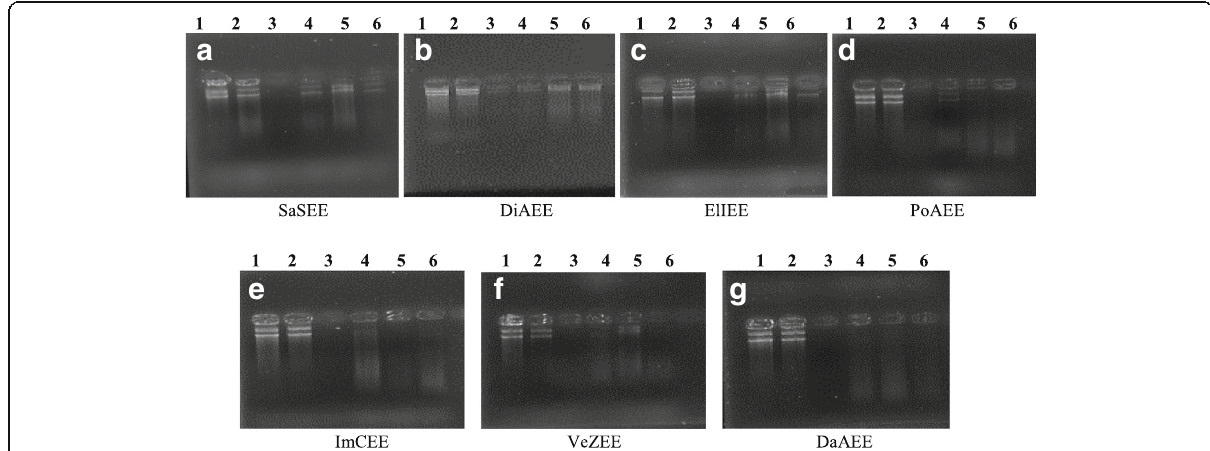
Fig. 4 Effects of the different ethanol plant extracts against oxidative damage to DNA (p1391Z). (Lane 1: Control genomic DNA; Lane 2: Fenton ’ s reagent + DNA; Lane 3: Fenton ’ s reagent + DNA + Quercetin; Lane 4: Fenton ’ s reagent + DNA + 2 μ l plant extract; Lane 5: Fenton ’ s reagent +